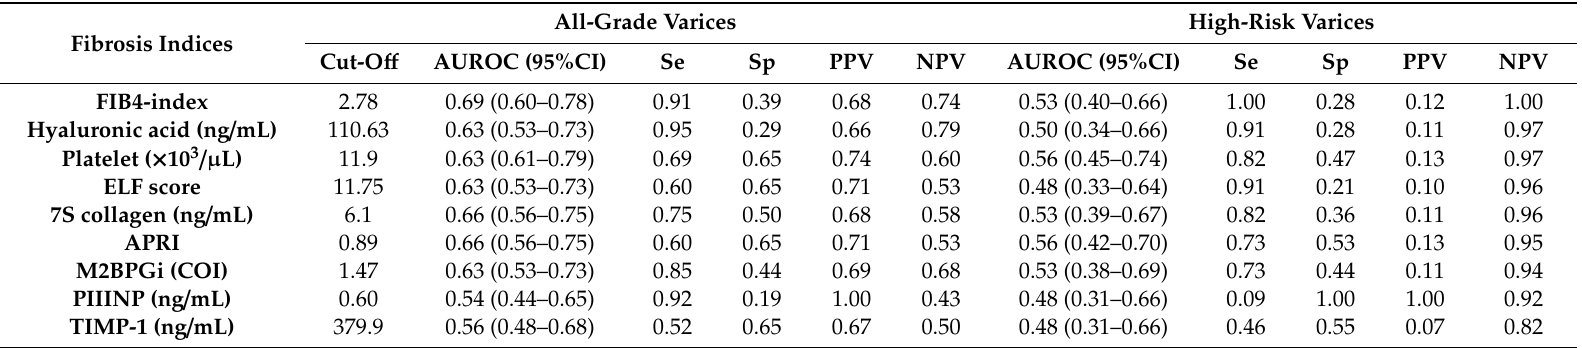
Table 2. Performance of fibrosis indices for the prediction of all-grade varices and high-risk varices in the estimation cohort ( n = 127). Fibrosis